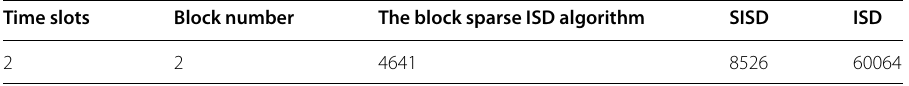
Table 1 The average CPU running time (second) for all algorithm Time slots Block number The block sparse ISD algorithm SISD ISD 2 2 4641 8526